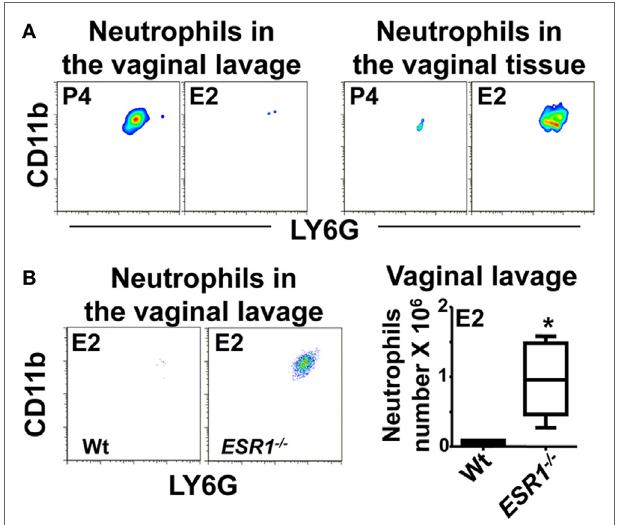
FigUre 1 | Neutrophils in the vaginal lavage. Hormone-treated ovariectomized mice were Candida albicans inoculated in the vagina for 6 h. (a) Representative flow cytometry plots of the neutrophils in the vaginal lavage and lower female reproductive tract tissue ( n = 5). (B) Representative flow cytometry plots and quantification of the neutrophils in the vaginal lavage of estradiol treated ESR1 − / − and Wt mice challenged with C. albicans . Data are expressed as box and whiskers 10–90 percentile ( n = 5). * p < 0.05 Mann–Whitney. Abbreviations: E2, estradiol; P4,